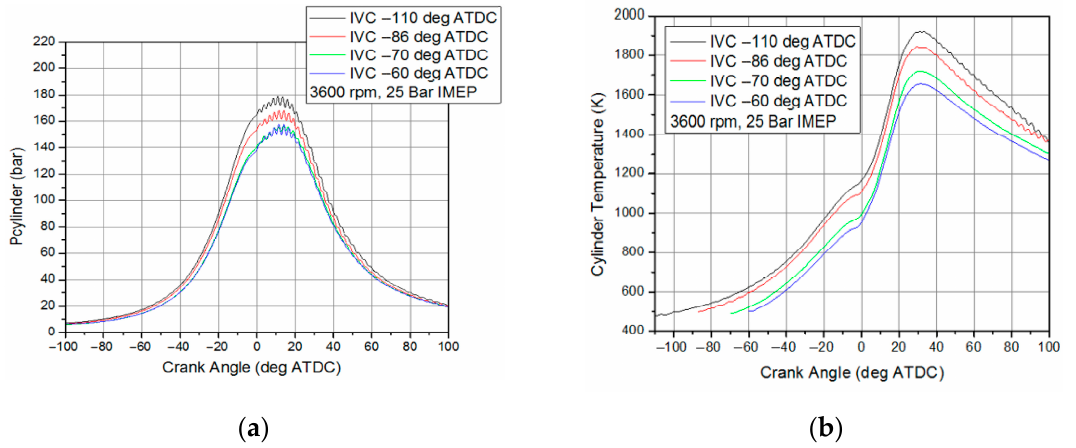
Figure 12. Comparison of ISFC with different intake closure angle and Lambda.